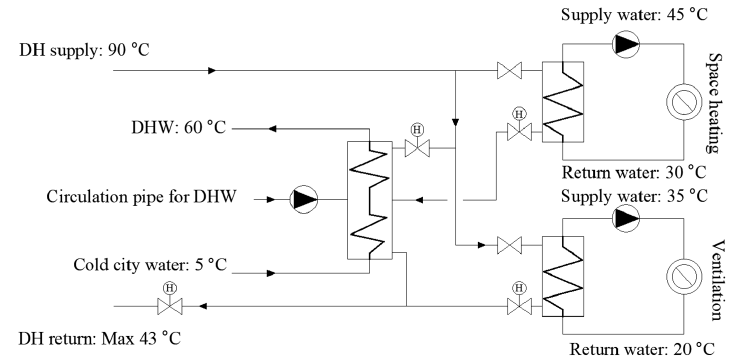
Figure 1. Original system connection and temperatures in design conditions (Substation 1). Buildings 2023 , 13 , x FOR PEER REVIEW